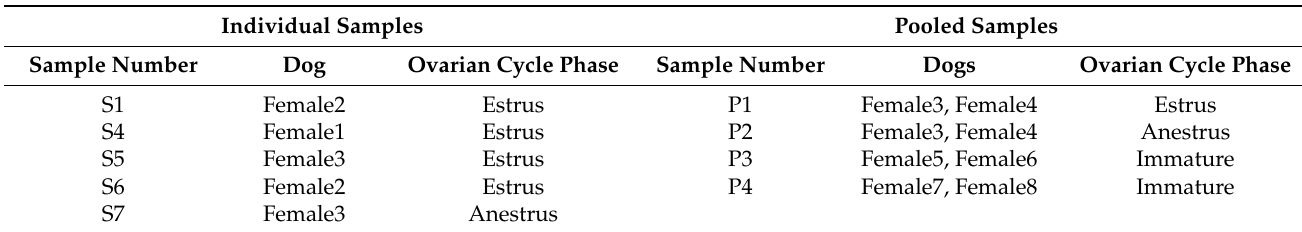
Table 1. Samples included in the